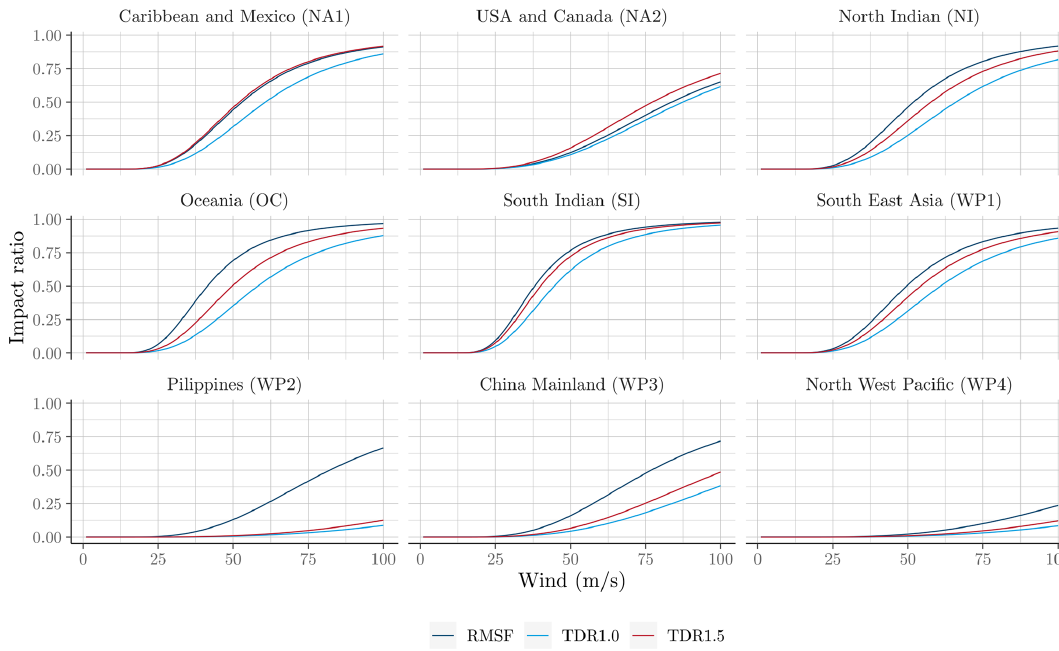
Figure A4. Regional optimal damage functions of the CLIMADA package (Eberenz et al., 2021).